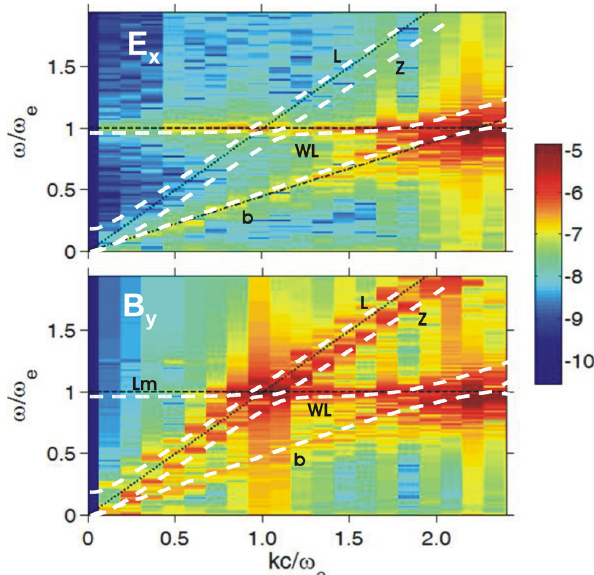
Fig. 12. ( ω , k ) spectrogram of the electric (on top) and magnetic field components (on bottom). Color scale indicates logarithmic magnitude. The dashed white lines represent the dispersion curves from fluid theory including the beam. The dotted black line marks the light curve, ω/k = c , which for ω > ω e is nearly identical with the L mode. Maximum electric and magnetic field intensity appear at the intersection of the whistler-Langmuir mode WL ( ω ∼ ω e ) with the Cerenkov beam mode b ( ω ∼ kV b ) . A second maximum of magnetic energy appears at the Gendrin point near kc/ω e = 1, ω ∼ ω e